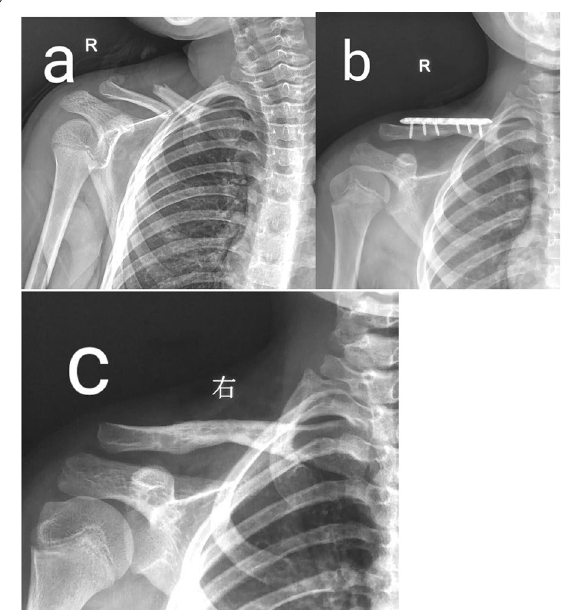
Fig. 2 Eleven-year-old boy with a right clavicle fracture treated with a plate. a AP view of the right clavicle before surgery. b AP view of the right clavicle after surgery. c AP view of the right clavicle after hardware removal